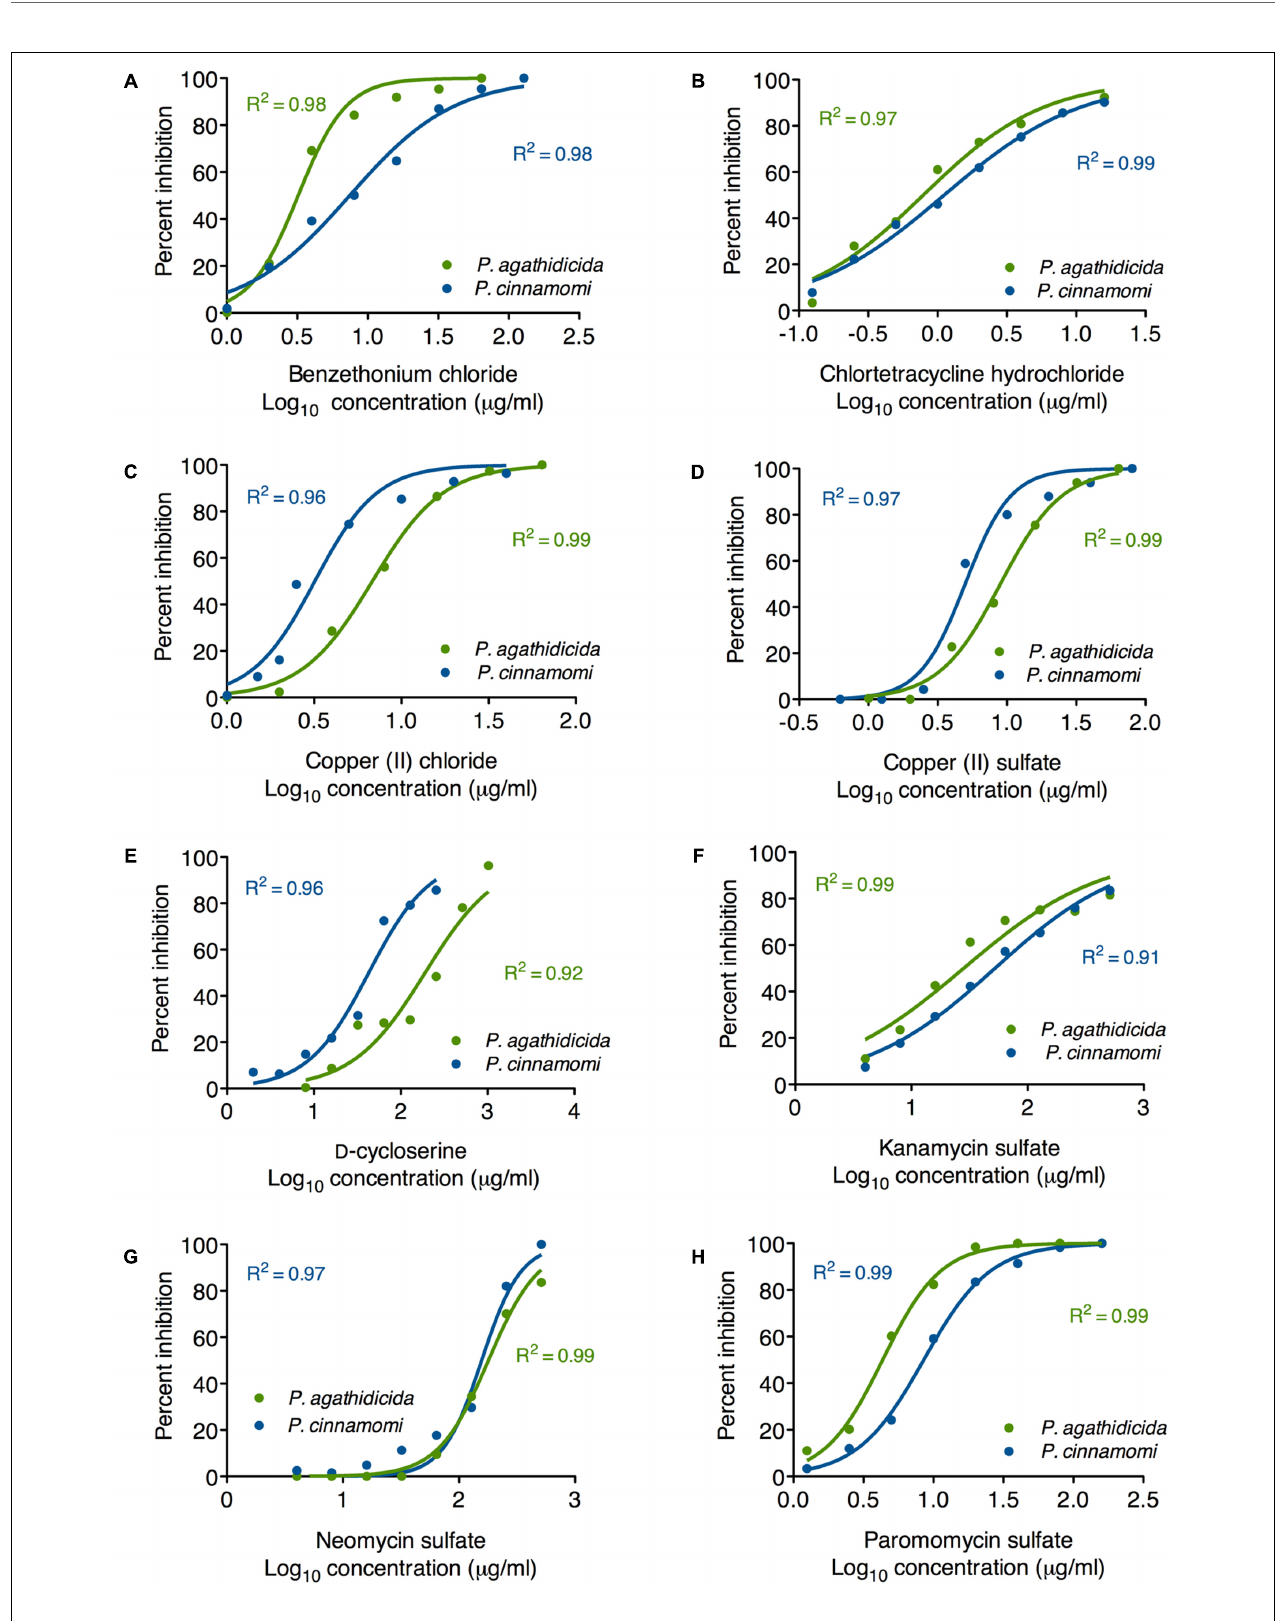
FIGURE 2 | Mycelial growth inhibition curves for P. agathidicida (green) and P. cinnamomi (blue). Each panel (A–H) shows the inhibition curves for a single compound, as identified in the label on the x -axis. Data points show the mean of triplicate inhibition assays.